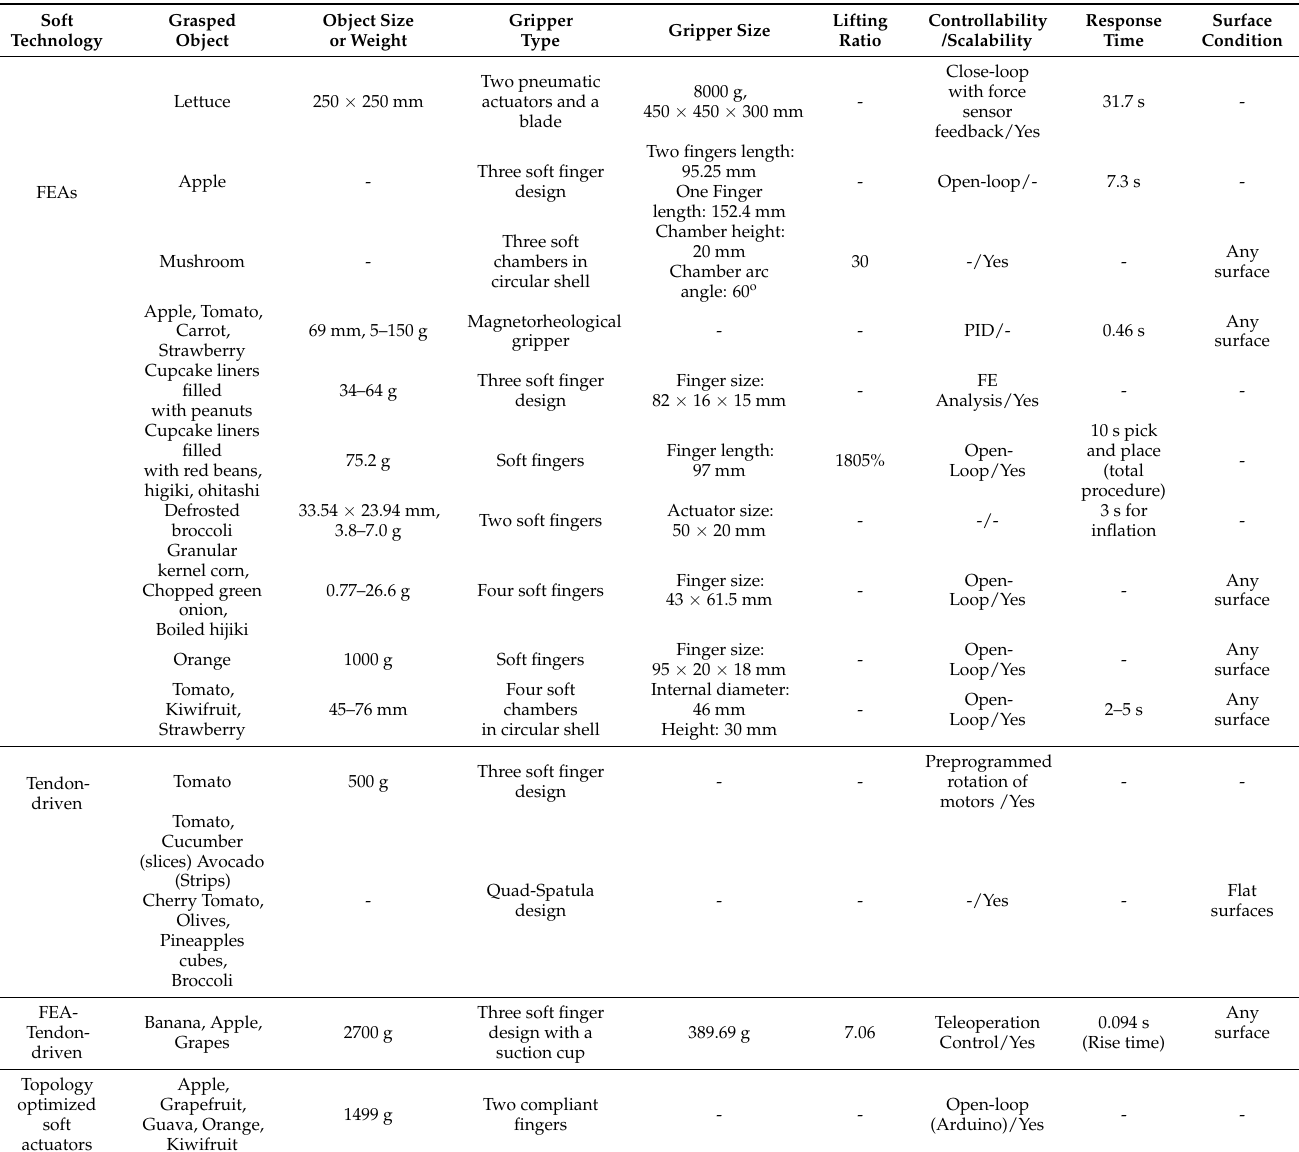
Table 1. Soft gripper technology, gripper type, size, lifting ratio, scalability and controllability, response time, and surface conditions